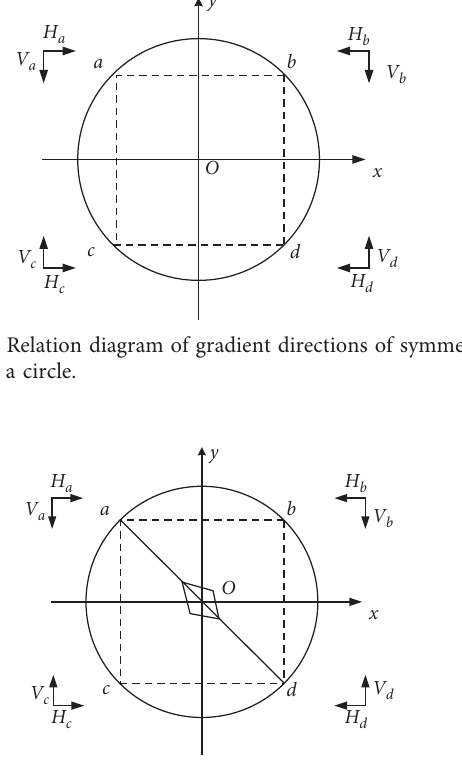
Figure 5: The location of the center of the voting